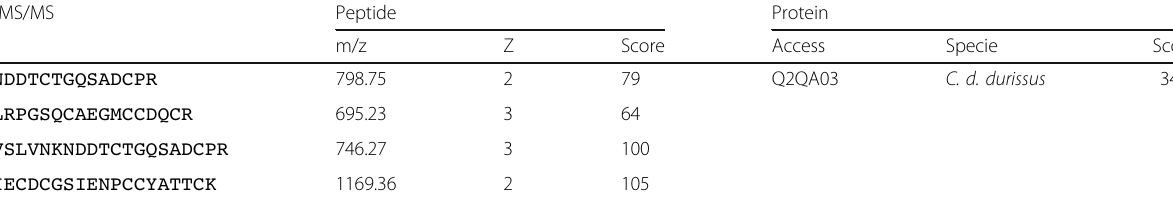
Table 2 Identification of non-RGD disintegrin peptides by MS/MS sequencing